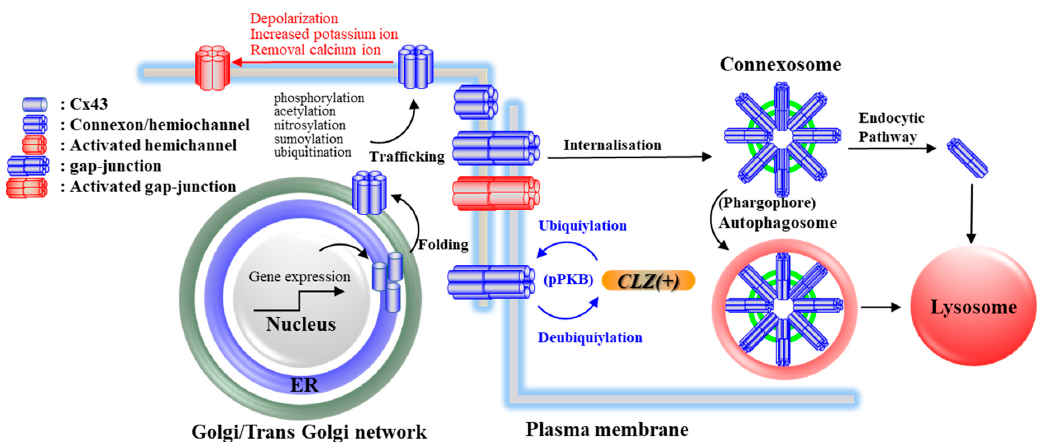
Figure 2. The life cycle of connexin43 (Cx43). Cx43 synthesis is regulated by several transcriptional factors (Sp1, activator protein 1 complex, cyclic AMP, and the Wnt pathway) and epigenetic processes (histone modifications, DNA methylation, and microRNA species). Synthesized six Cx43 fold oligomerise to form a connexon in the endoplasmic reticulum (ER) and trans-Golgi network. Trafficked connexons to the plasma membrane become hemichannels as functional connexons, and dock with connexons on neighbouring cells to form gap-junctions. The trafficking process of connexons is regulated by various signalling systems, including phosphorylation, acetylation, nitrosylation, sumoylation, and ubiquitination. CLZ likely activates connexon trafficking via enhanced ubiquitylation via the phosphorylation of protein kinase B (pPKB). Both hemichannels and